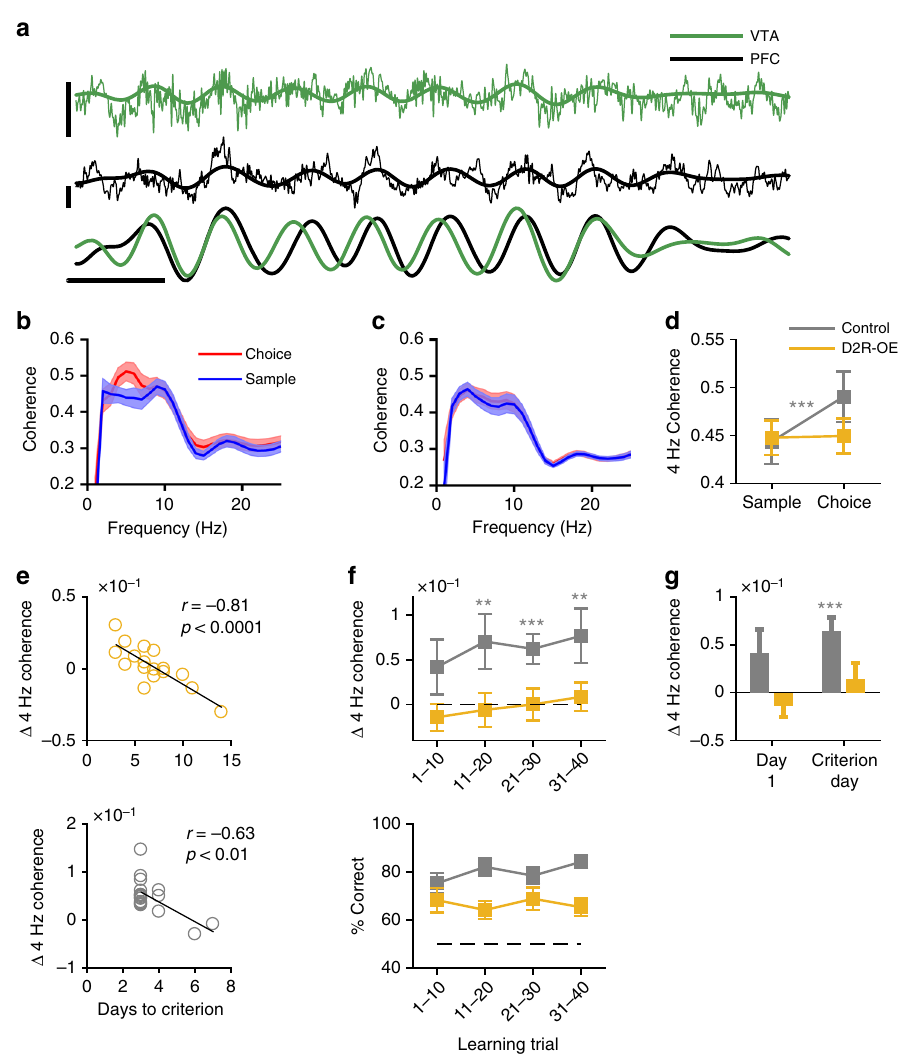
Fig. 3 Working memory de fi cits are associated with impaired 4 Hz VTA-PFC synchrony in D2R-OE mice. a Example of simultaneously recorded LFP traces in the VTA (top, green) and PFC (middle, black). Thin lines represent the raw LFP whereas thick lines represent the LFP signal fi ltered between 3 and 6 Hz. The bottom graph shows the normalized 3 – 6 Hz fi ltered signals in the two structures, revealing coherent 4 Hz oscillations. Scale bar: 250 ms; 0.2 mV. b , c LFP coherence in sample and choice phases in control ( b ) and D2R-OE ( c ) mice. d Four Hertz coherence (calculated by averaging between 3 and 6 Hz) during sample and choice phases in the two genotypes. A selective increase in 4 Hz coherence was observed in control ( n = 19, *** p < .001, sign-rank test) but not D2R-OE ( n = 17, p = 0.62) animals. e Change in 4 Hz VTA-PFC coherence (choice minus sample, Δ ) plotted against learning rate (days to criterion) for each D2R-OE (top) and control (bottom) mouse. Animals that showed a greater increase in coherence in the choice phase learned the task more rapidly (D2R-OE: r = − 0.81, p < .0001; Control: r = − 0.63, p < .01, Pearson ’ s correlation). f Change in coherence from sample to choice (top) and behavioral performance (bottom) during the fi rst 40 trials of training (4 days). Control animals showed an increase in coherence only during trials 11 – 40 ( n = 19, *** p < .001, ** p < .01, sign-rank test). g Change in coherence on fi rst day of training and the day when criterion performance was reached. D2R-OE mice did not show an increase in coherence during training, even on the day when criterion was reached ( n = 17, p = 0.62). Shaded regions and error bars represent mean ± s.e.m measured across